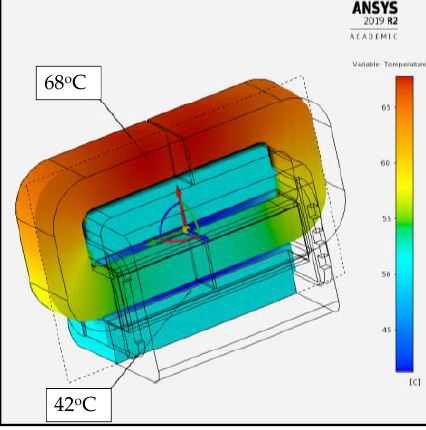
Figure 8. ANSYS AIM simulation for the thermal distribution of an inductor.